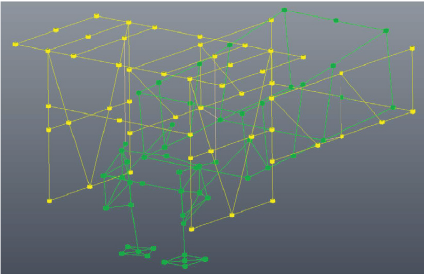
Figure 13: The paste point arrangement